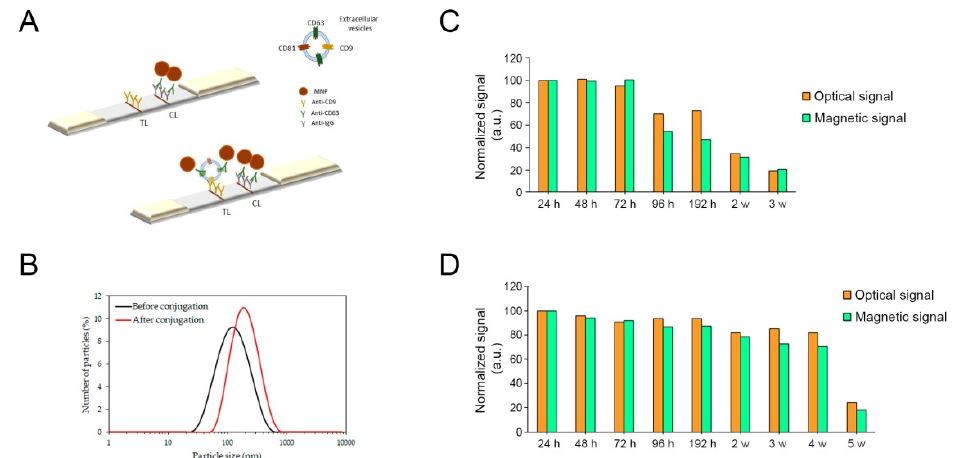
Figure 1. ( A ) Simplified schematic illustration of the LFIA. Specific antibodies against tetraspanins (test, TL) and anti-mouse immunoglobulin antibodies (control, CL) are immobilized on the membrane. Blank test (upper graph): when there are no extracellular vesicles in the sample, the test line does not appear. Sample test (bottom graph): when there are extracellular vesicles in the sample, they are detected by the detection of the complex MNPs-Ab displaying the test line. ( B ) Hydrodynamic size distribution profiles of superparamagnetic iron oxide nanoparticles before (solid black line) and after the conjugation with anti CD63 antibody concentration of 1 mg/mL (red). ( C ) MNPs-Ab conjugates stability measurements at room temperature for 24, 48, 72, 96, 192 hours (h) h, 2 and 3 weeks (w). ( D ) MNPs-Ab conjugates stability measurements at 4 °C for 24, 48, 72, 96, 192 h, 2, 3, 4 and 5 weeks.